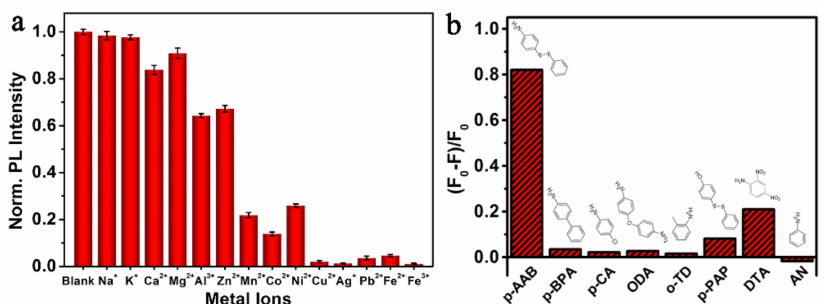
Figure 8. ( a ) The normalized PL intensity histograms of aqueous Cu NCs@AA incubated with di ff erent nitrate metal ions. ( b ) The e ff ect of di ff erent aniline compounds on the PL intensity of Cu